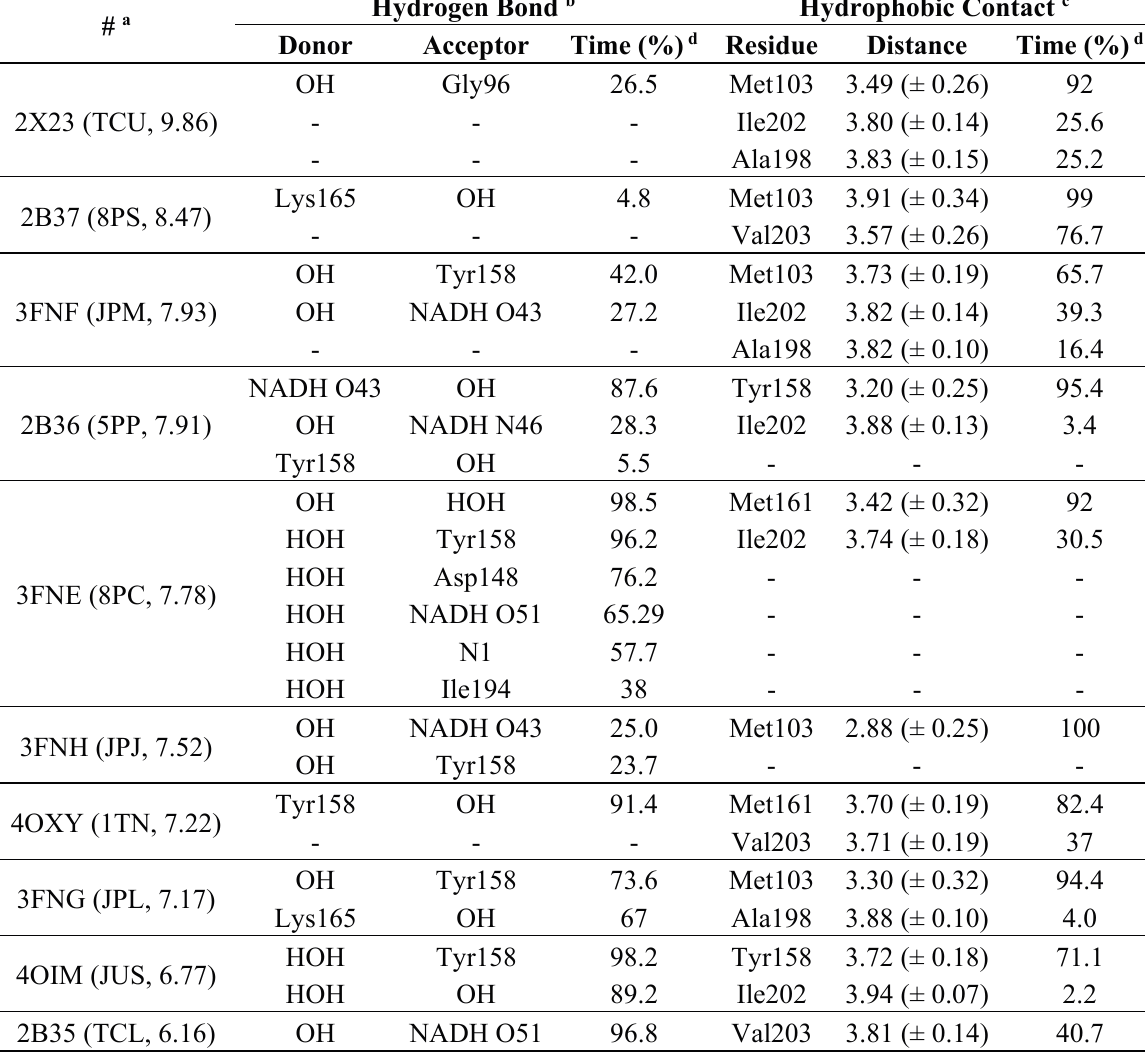
Table 3. Hydrogen bond and hydrophobic contact interactions between the diphenyl ethers inhibitors and InhA-NADH during the last 5 ns of the MD simulations of complexes: 2X23 (InhA-NADH-TCU), 2B37 (InhA-NADH-8PS), 3FNF (InhA-NADH-JPM), 2B36 (InhA-NADH-5PP), 3FNE (InhA-NADH-8PC), 3FNH (InhA-NADH-JPJ), 4OXY (InhA-NADH-1TN), 3FNG (InhA-NADH-JPL), 4OIM (InhA-NADH-JUS), and 2B35